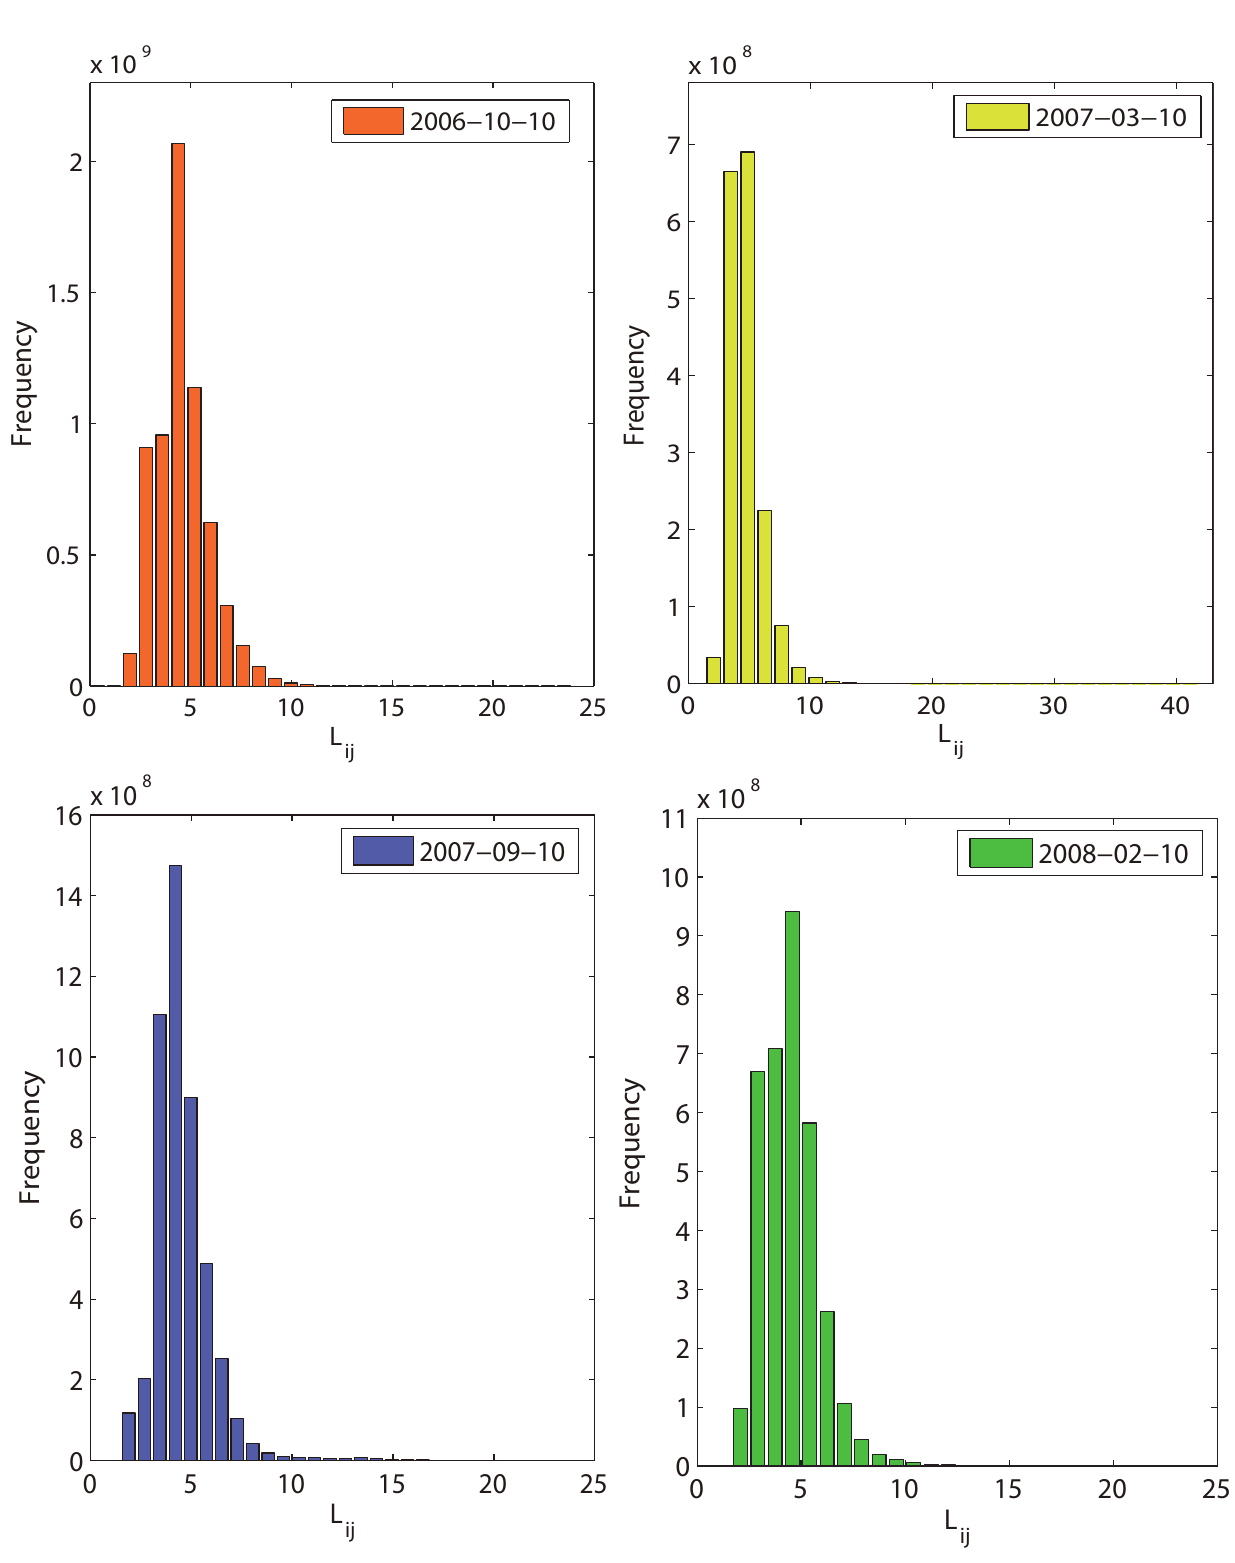
Fig 2. The distribution of flow distances ( l ij ) on October 10, 2006, March 10, 2007, September 10, 2007, and February 10,